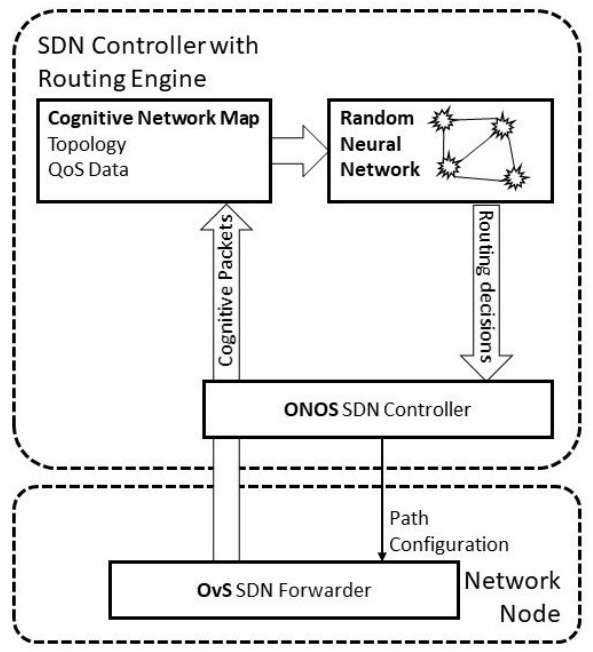
Figure 4. Internal architecture of the SDN solution with